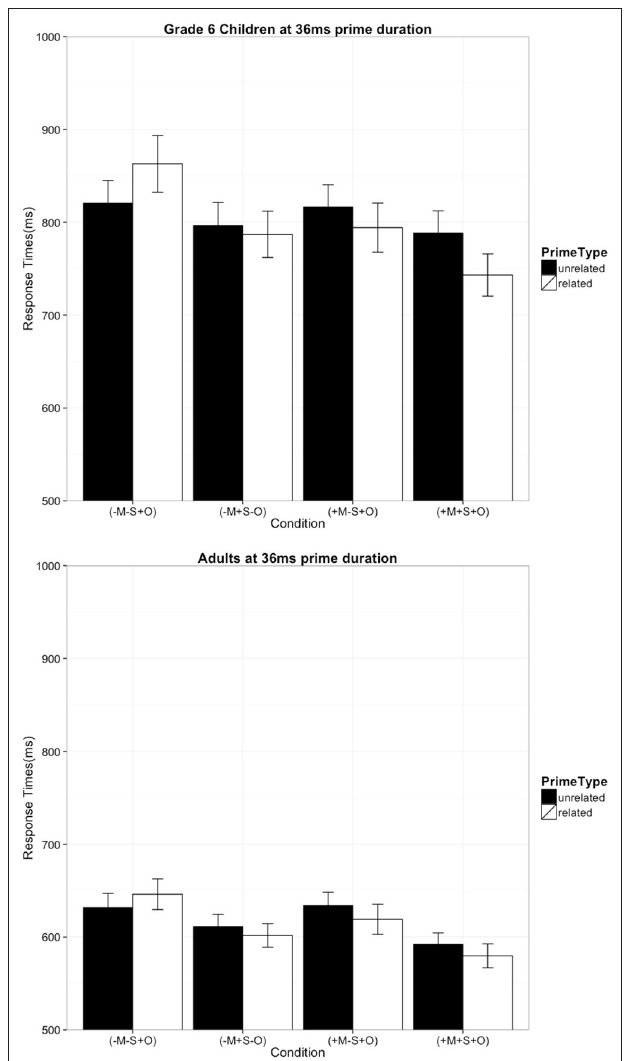
FIGURE 1 | Priming effects in reaction times in Experiment 1.